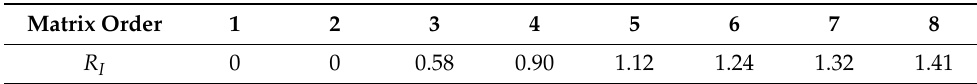
Table 2. Standard value of random consistency index, R I